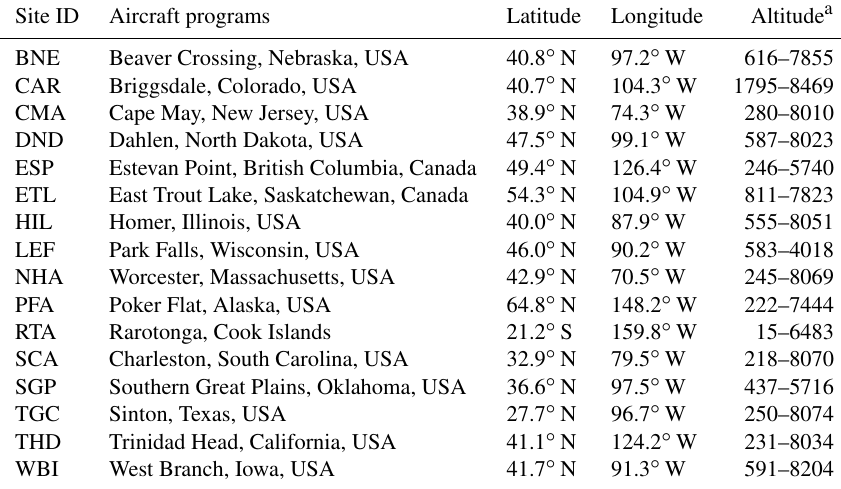
Table A2. Aircraft flask measurement programs.